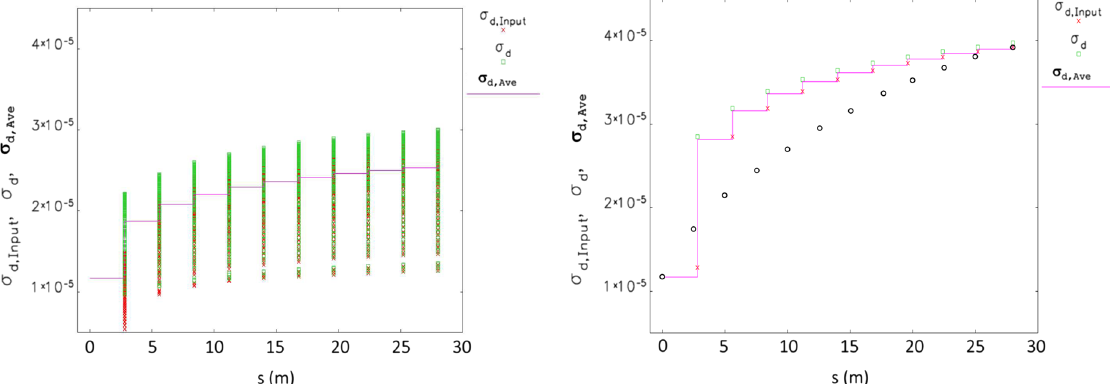
FIG. 3. Electron beam slice rms fractional energy spread along the FODO channel in the presence of IBS, for the sliced (left) and unsliced beam. Beam energy is 150 MeV. For the sliced beam, the fractional energy spread is shown for each slice; its average value over ” is the energy spread at the entrance of each “ IBS module ” depicted in all slices is also shown with the solid line. In the legend, “ σ d ; Input ” is the energy spread at the exit of each IBS module and “ σ ” is the rms fractional energy spread, averaged over all ELEGANT; “ σ d d ; Ave bunch slices. An “ IBS module ” is a zero-length lattice element; ELEGANT calculates the integrated IBS growth rates between the modules, then scatters particles at each module. The beam ’ s parameters are updated for use in downstream elements. For the unsliced beam, the rms fractional energy spread estimated with Eq. (3) is also shown (circles).